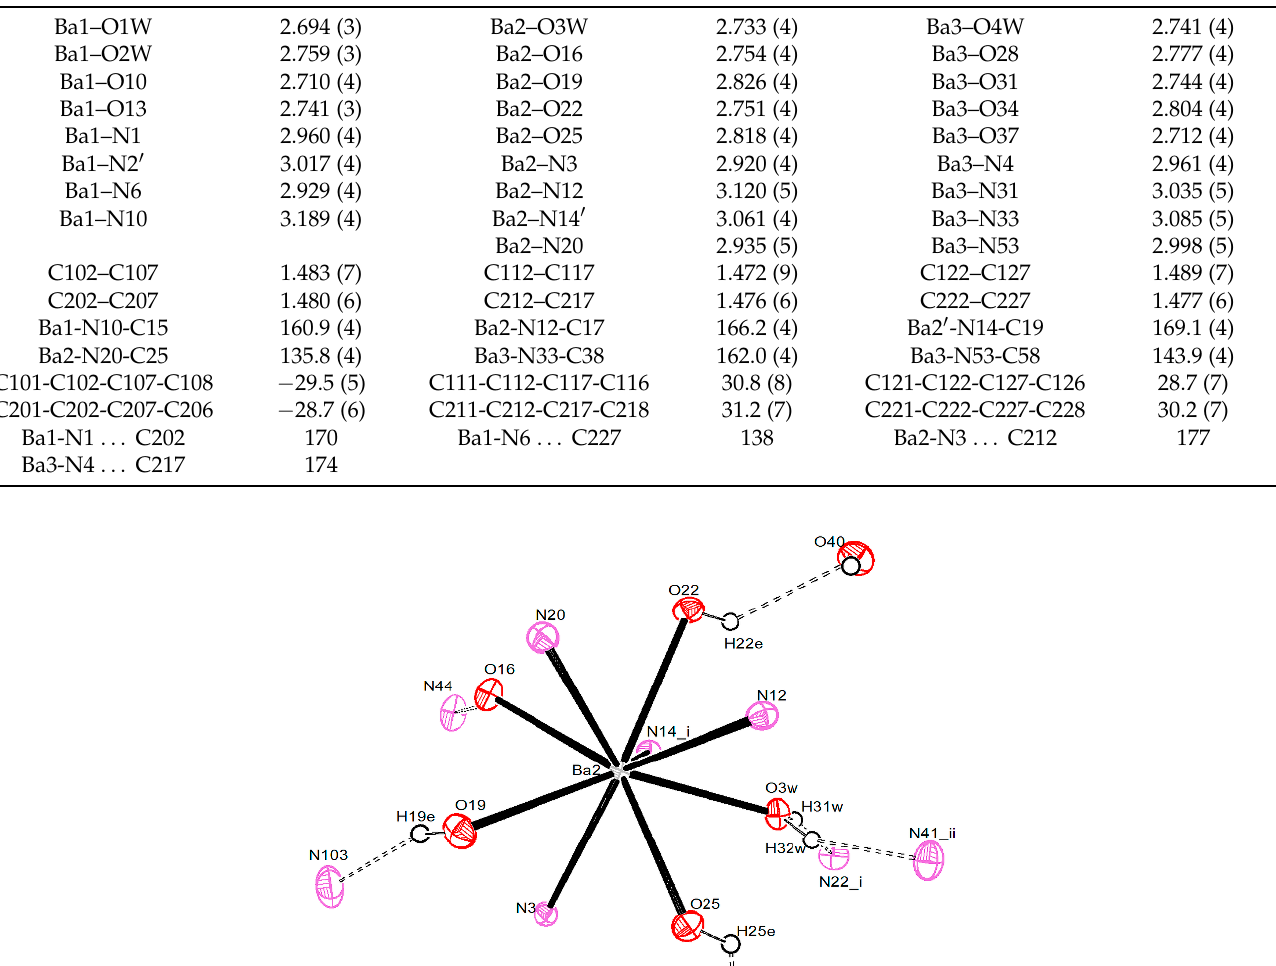
Figure 22 . The first and second coordination spheres of Ba3.